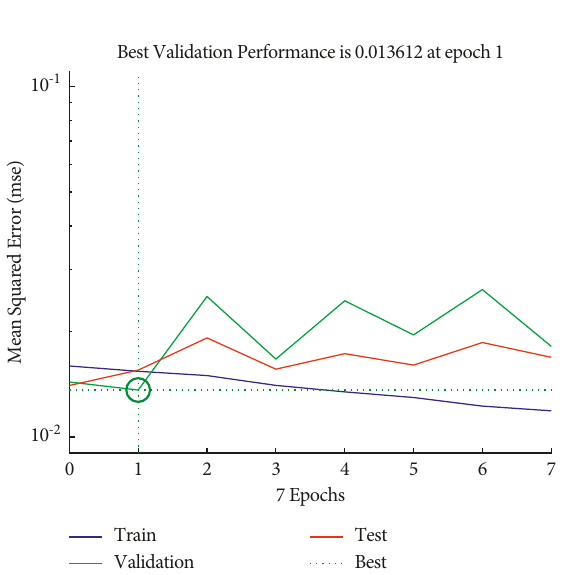
Figure 4: Model iteration